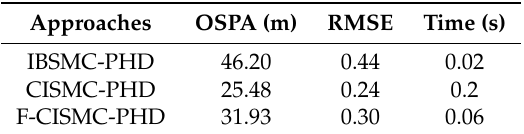
Figure 5. Estimated numbers and RMSEs of IBSMC-PHD, CISMC-PHD and F-CISMC-PHD approaches with clutter number being 10. ( a ) Estimated numbers of the three approaches; ( b ) RMSEs of the three approaches. Table 5. Averaged Estimation Errors and Computational Times per 100 particles.